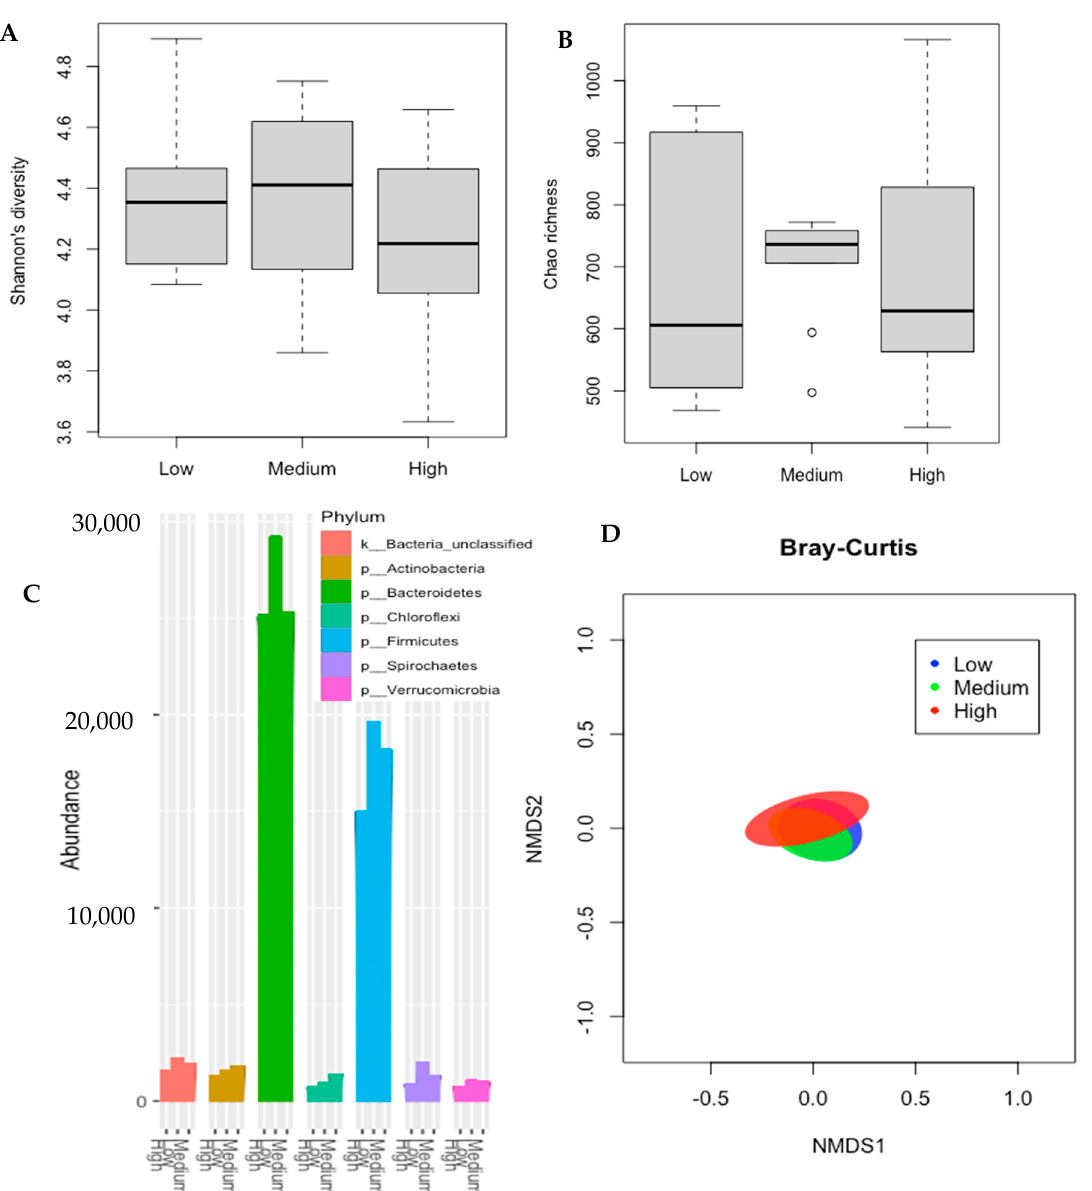
Figure 2. Shannon’s diversity index ( A ) and Chao’s richness estimator ( B ) for microbial communities in the rumen of Nellore cattle classified by RFI. Relative abundance of the top seven phylum of ruminal bacterial communities observed in different RFI groups Nellore cattle ( C ). Non-metric multidimensional scaling (NMDS) representation of the Bray–Curtis dissimilarity metric for ruminal content of Nellore cattle classified by RFI ( D ).